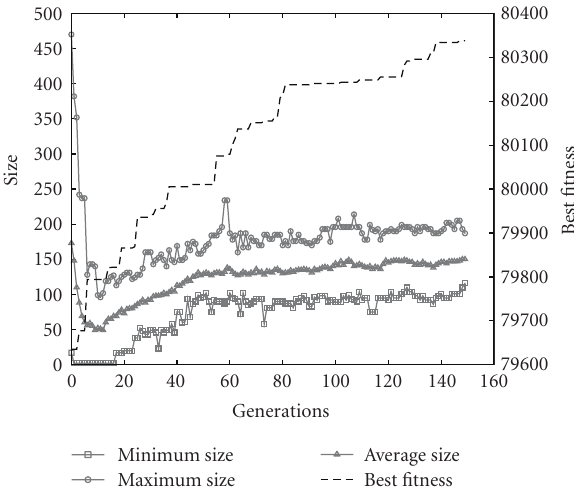
Figure 10: Symbolic regression Experiment 5: chromosome sizes and best